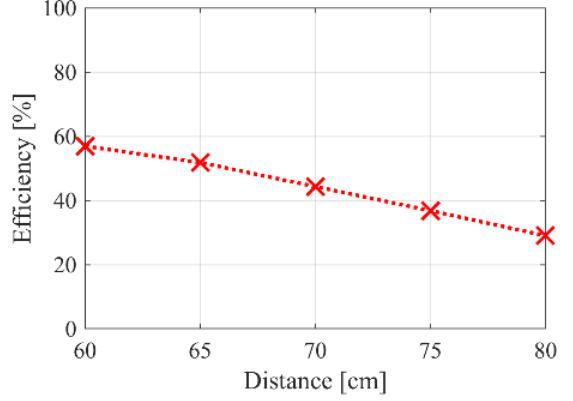
Figure 18. Estimated percentage losses of the developed system.